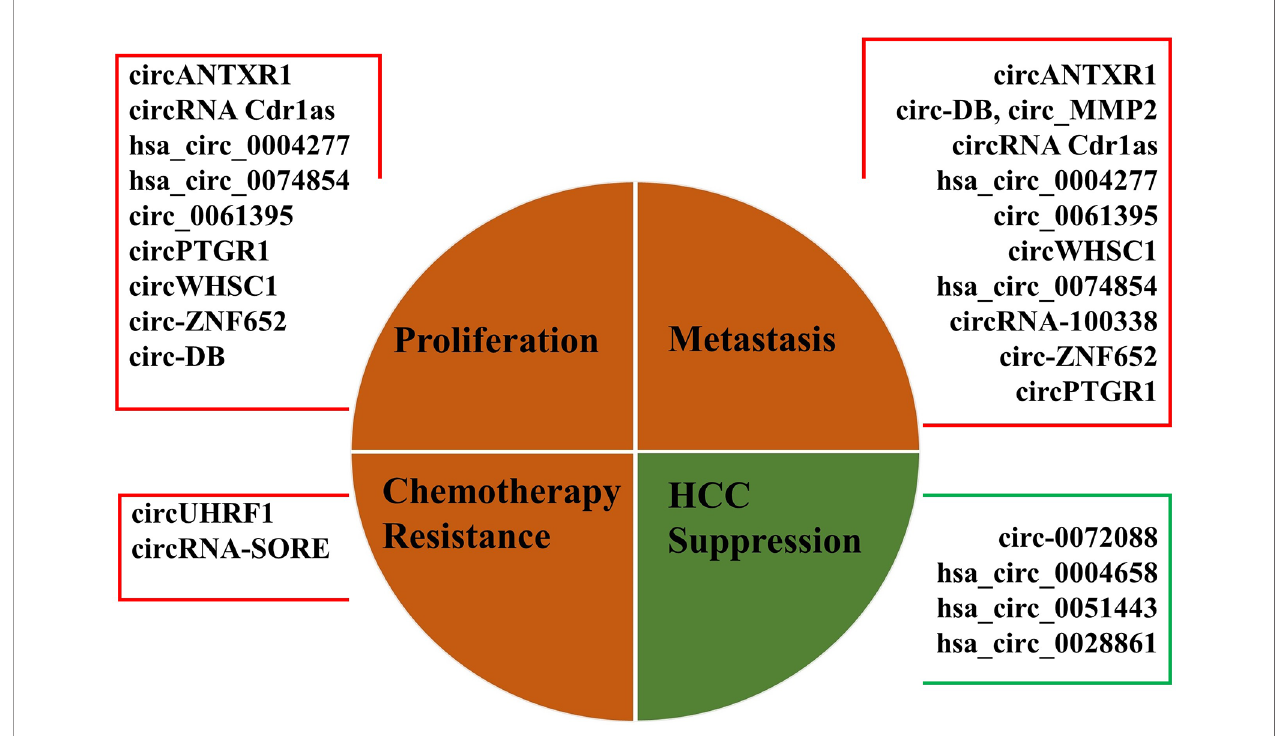
FIGURE 1 | Representation of main biological functions of dysregulated exosomal circRNAs in